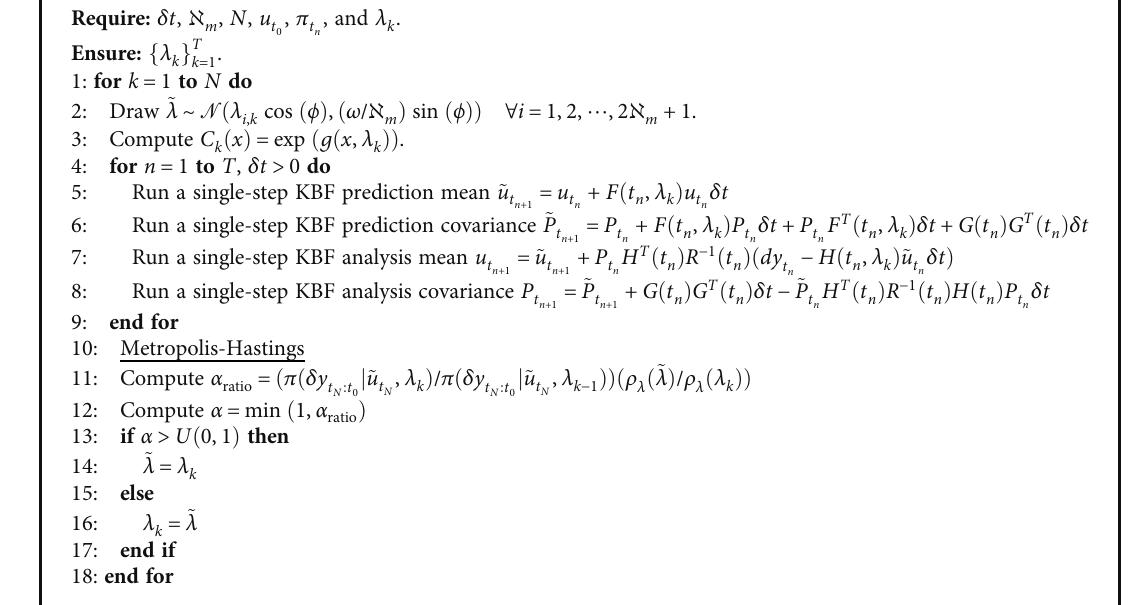
Algorithm 2: KBF likelihood with